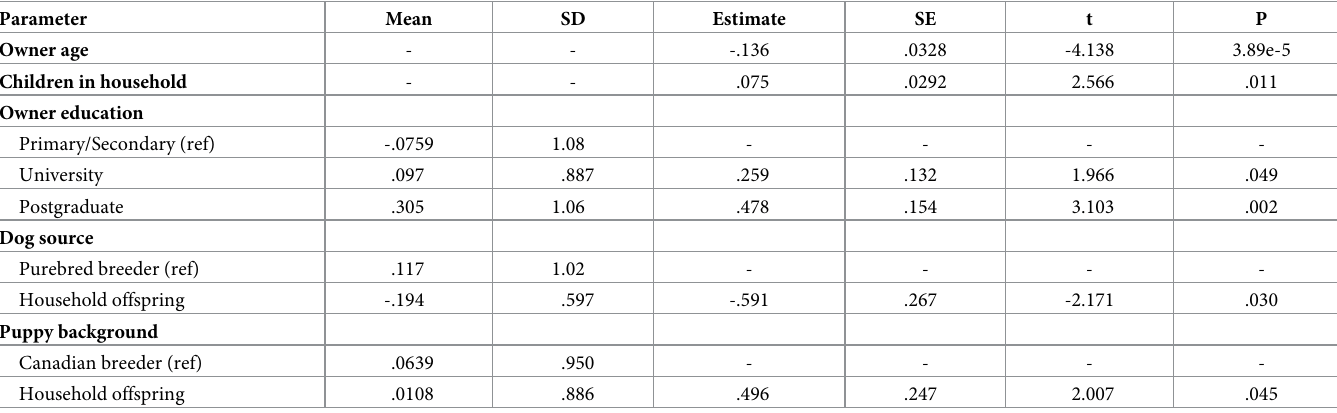
Table 7. Statistically significant interactions of owner and dog parameters on MDORS Factor 2